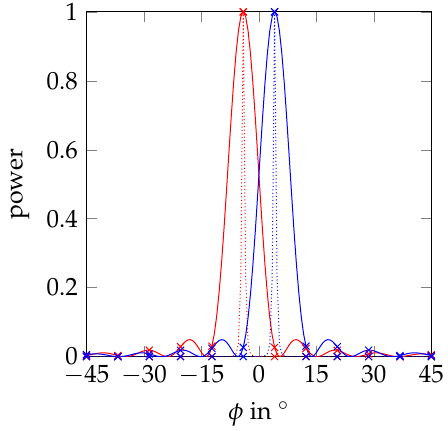
Figure 2. Spatial power distribution at N rx = 12 receive branches ( ) in case of Bartlett beamforming ( ) and in case of a combination with eigenspace-based post-processing ( ) considering two incident waves ( / ) and a field of view (FoV) of Φ = π /2. The optimal solution in terms of spatial filtering and maximizing the SINR is obtained